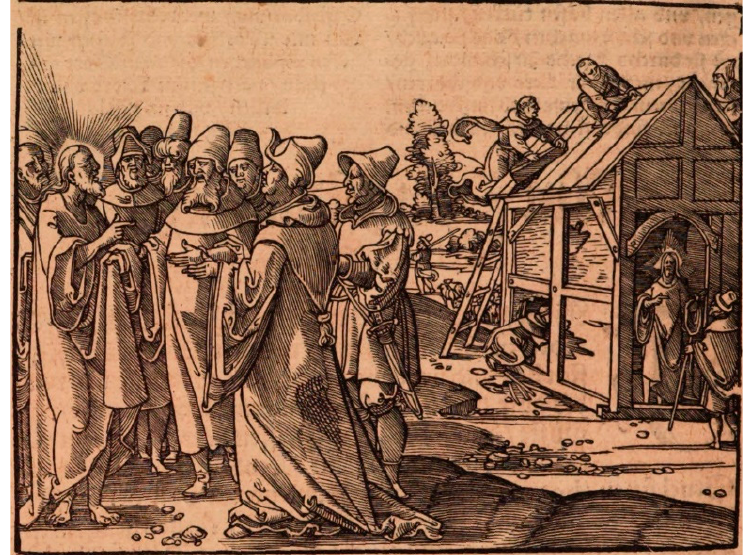
Figure 4. Hans Brosamer, Parable of the sheepfold [H 1038], ca. 1544, in (Luther 1544c) part 2, fol. CXXXv (Munich, Bayerische Staatsbibliothek, 2 Hom. 306-3, urn:nbn:de:bvb:12-bsb-10 144065-2; NoC-NC/1.0).